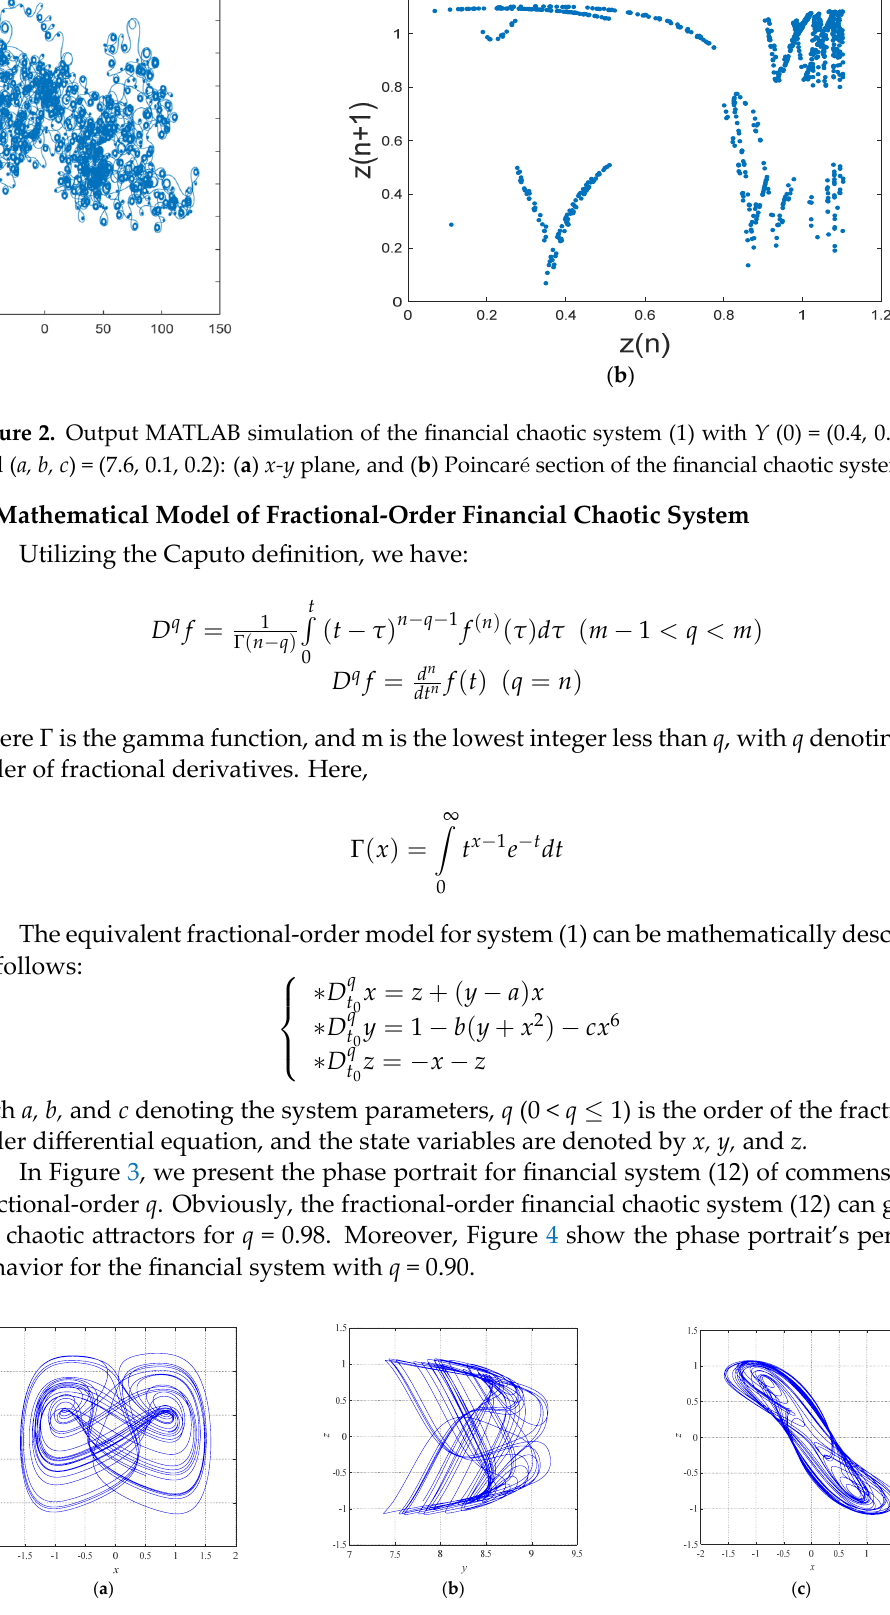
Figure 3. Phase diagrams for q = 0.98, (𝑎,𝑏,𝑐) = (7.6,0.1,0.2) with x (0) = 0.4, y (0) = 0.2, z (0) = 0.5: ( a ) x-y plane, ( b ) y-z plane, and ( c ) x-z plane.